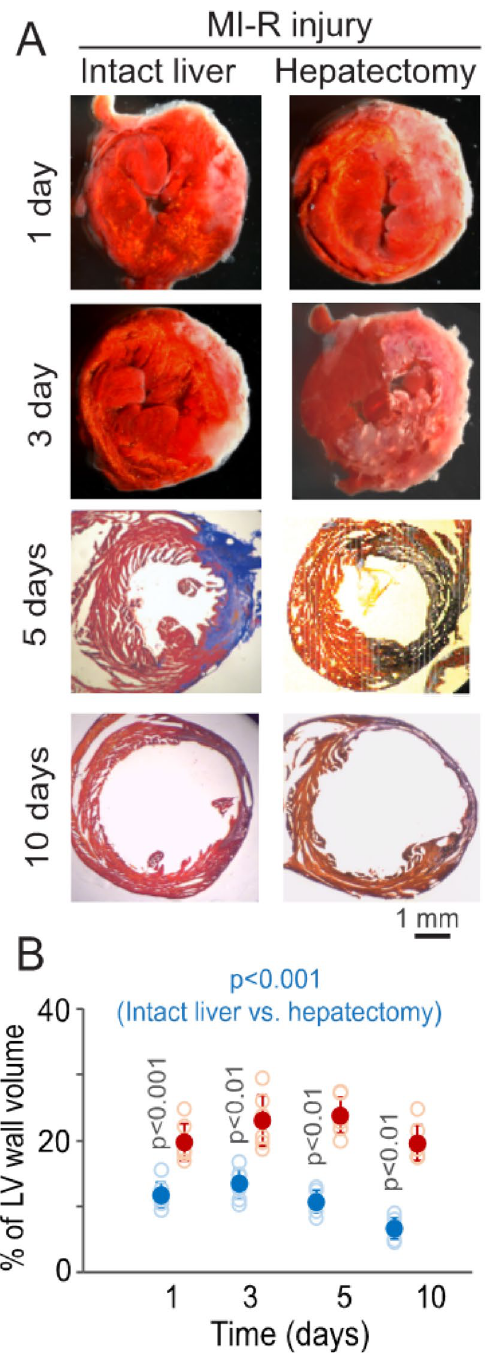
Figure 3. Myocardial infarction in liver-intact and hepatectomized parabiotic mice. ( A ) Left ventricular specimens from liver-intact and hepatectomized parabiotic mice, showing TTC-stained myocardial infarcts (pale) at 1 and 3 days and AZAN-stained myocardial infarcts/fibrotic tissue (blue) at 5 and 10 days after MI-R injury. Red: Intact myocardium. The length scale is for all panels. ( B ) Graphic representation of the % of myocardial infarcts in reference to the total volume of the left ventricular wall. Solid blue and red circles: Means ± SDs from liver-intact and hepatectomized parabiotic mice with MI-R injury, respectively. Open blue and red circles: Raw data points (n = 6) from liver-intact and hepatectomized parabiotic mice with MI-R injury, respectively. The blue-colored p value is for comparison between the liver-intact and hepatectomized mice by ANOVA. The p value on each blue-colored column is for post-hoc comparison between the liver-intact and hepatectomized mice at each time